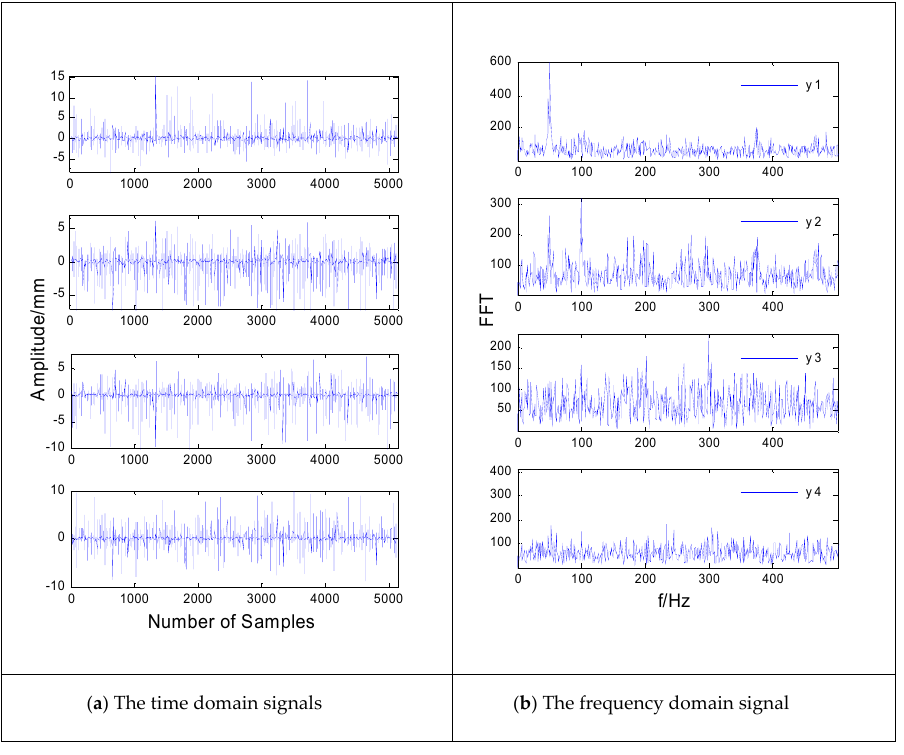
Figure 9. The signals separated by the SOBI algorithm. Appl. Sci. 2020 , 10 , x FOR PEER REVIEW